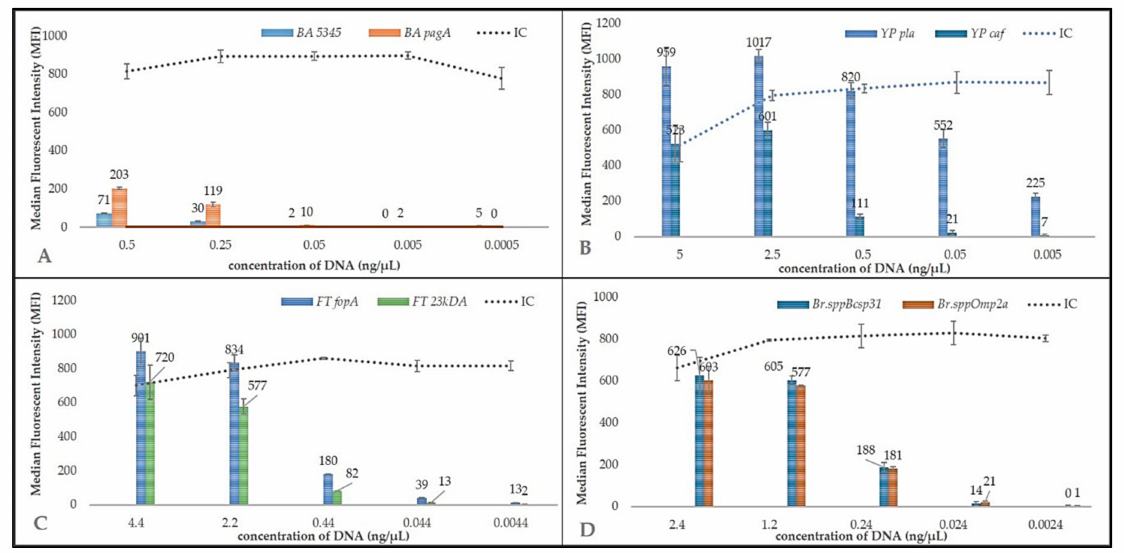
Figure 4. Sensitivity test.—The detection limit of the MOL-PCR system was performed in the form of a concentration gradient of isolated DNA of all bacteria and for two targets, namely: ( A ) B. anthracis , ( B ) Y. pestis , ( C ) F. tularensis , ( D ) B.